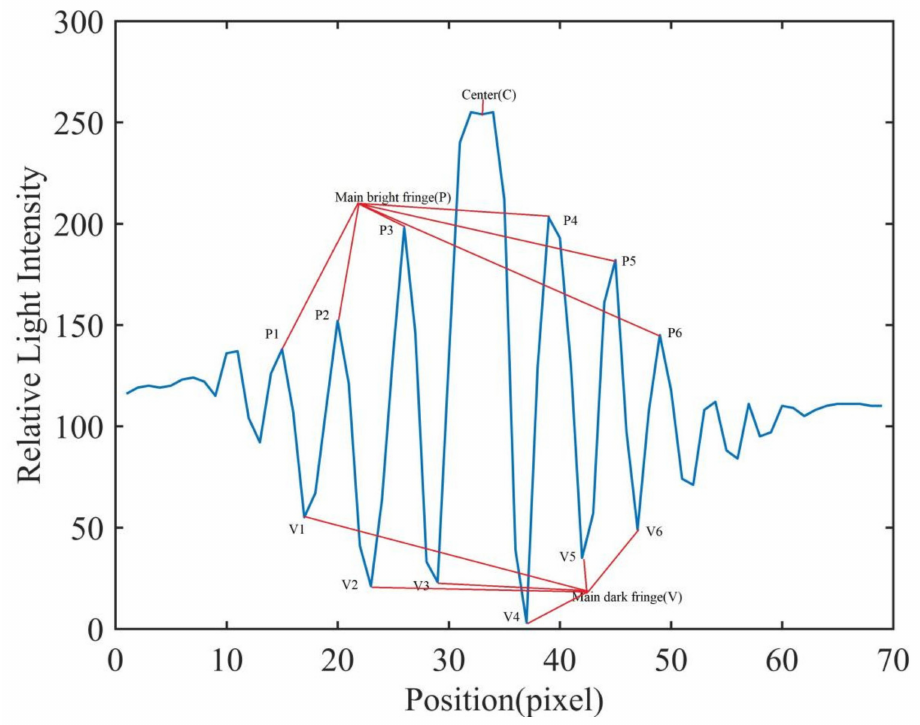
Figure 4. The relative light intensity distribution of fungal spore diffraction